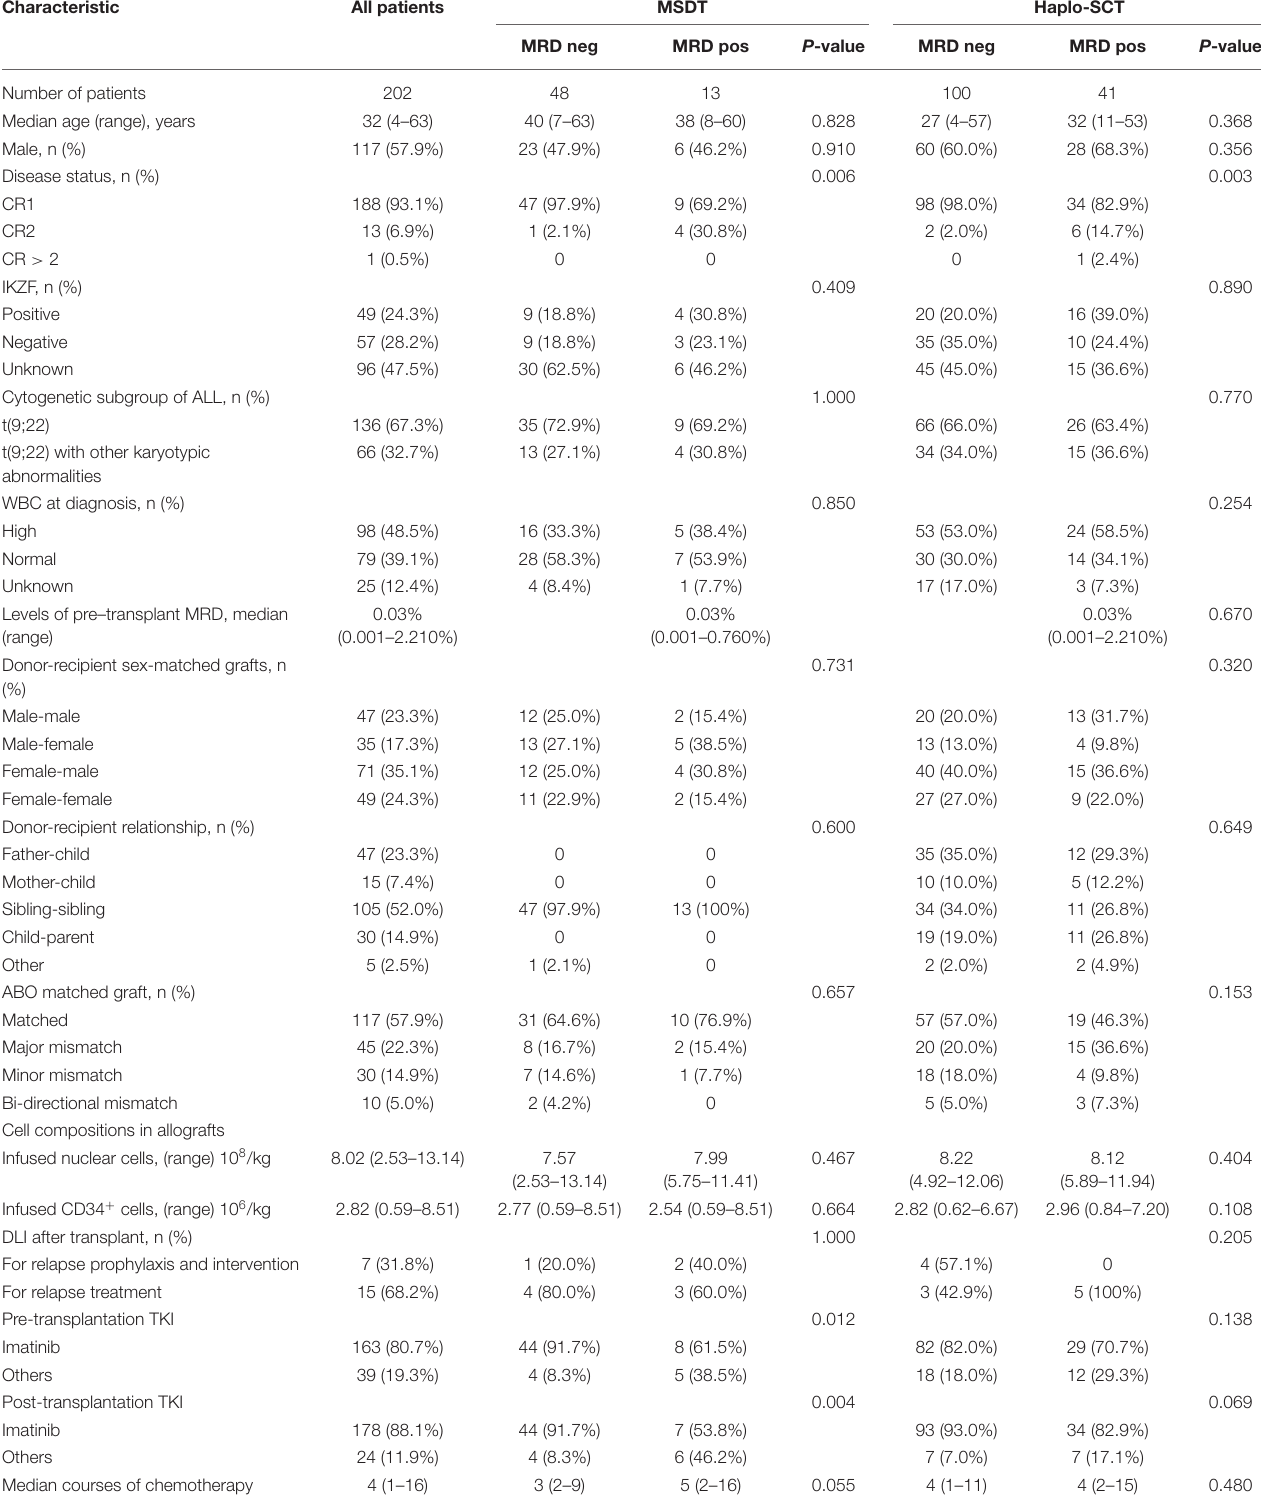
TABLE 1 | Patient and donor characteristics ( n =